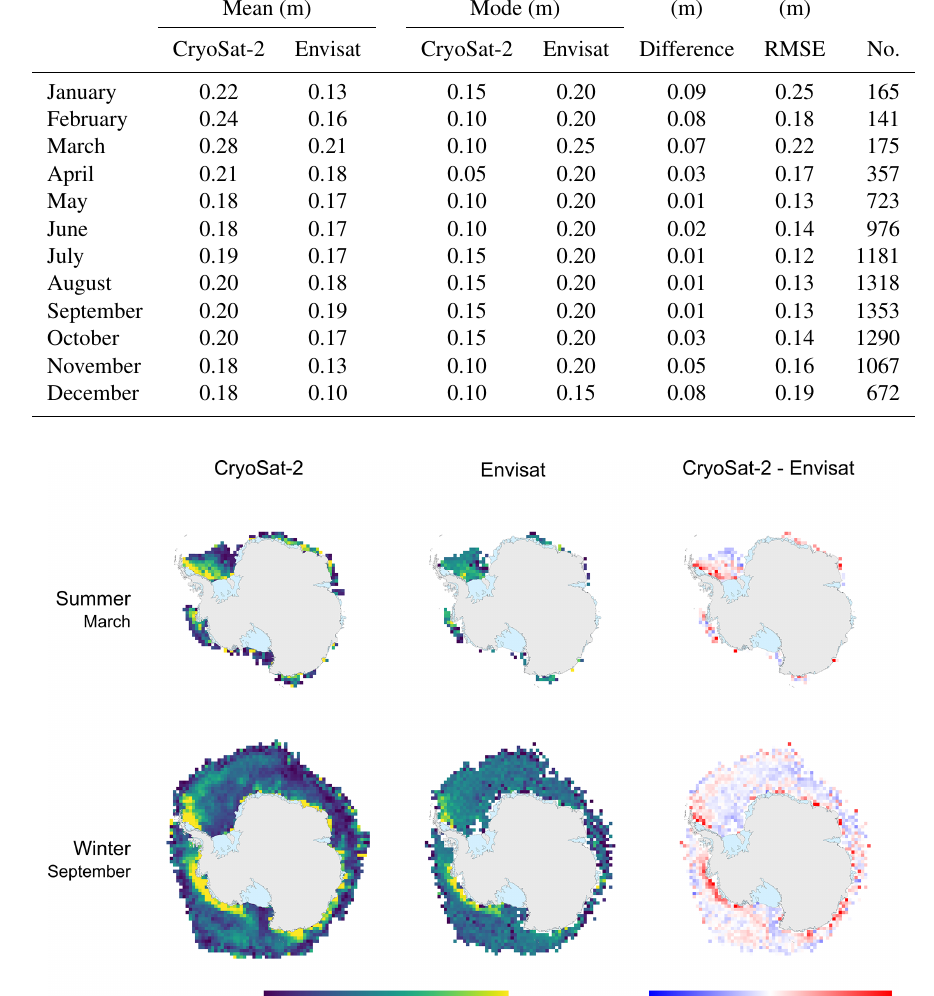
Table 2. Modal and mean freeboard, difference between CS-2 and Envisat and root-mean-square error (RMSE) for Antarctic-wide averages.